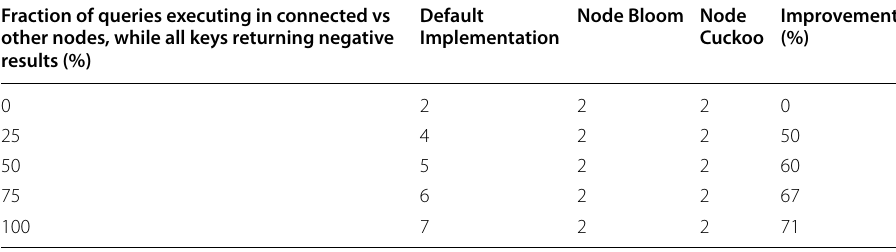
Table 6 Experimental results 2: lookup performance when remote nodes do not contain data against queried partition key. Query execution time in milliseconds Fraction of queries executing in connected vs other nodes, while all keys returning negative results (%)